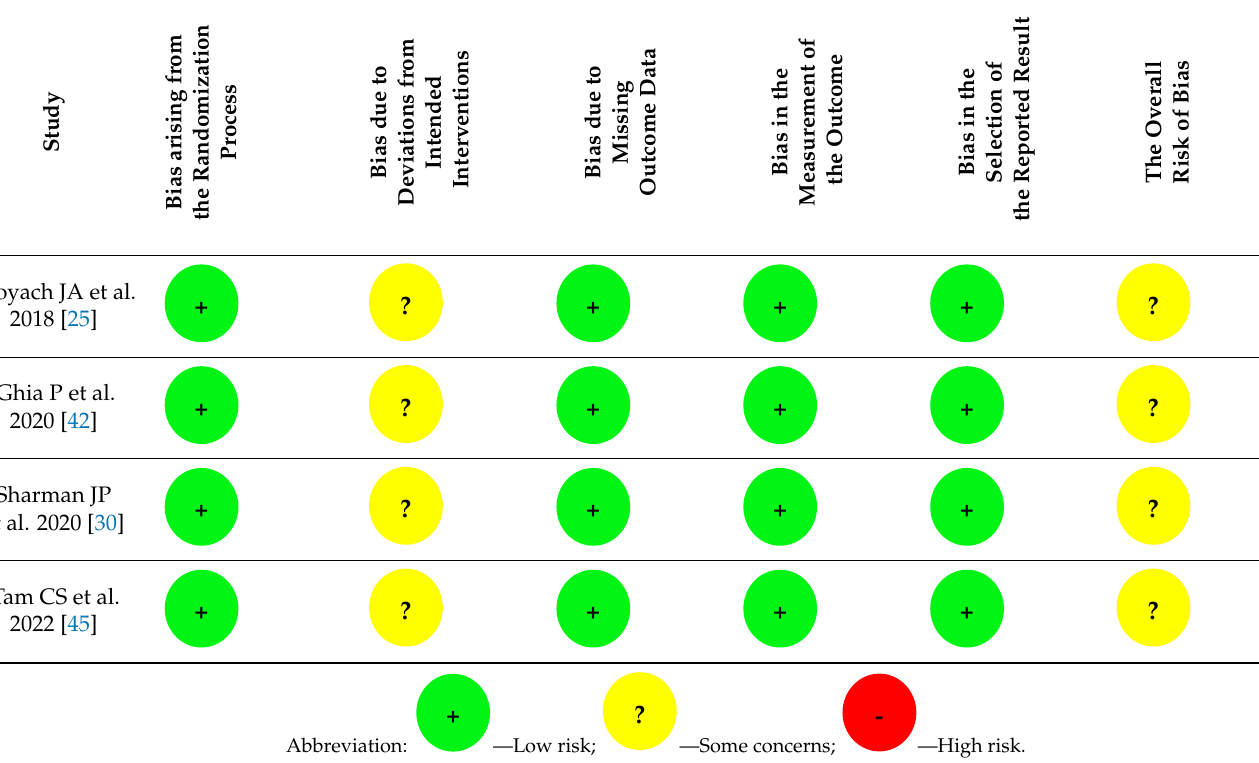
—Low risk; —Some concerns; — High risk.